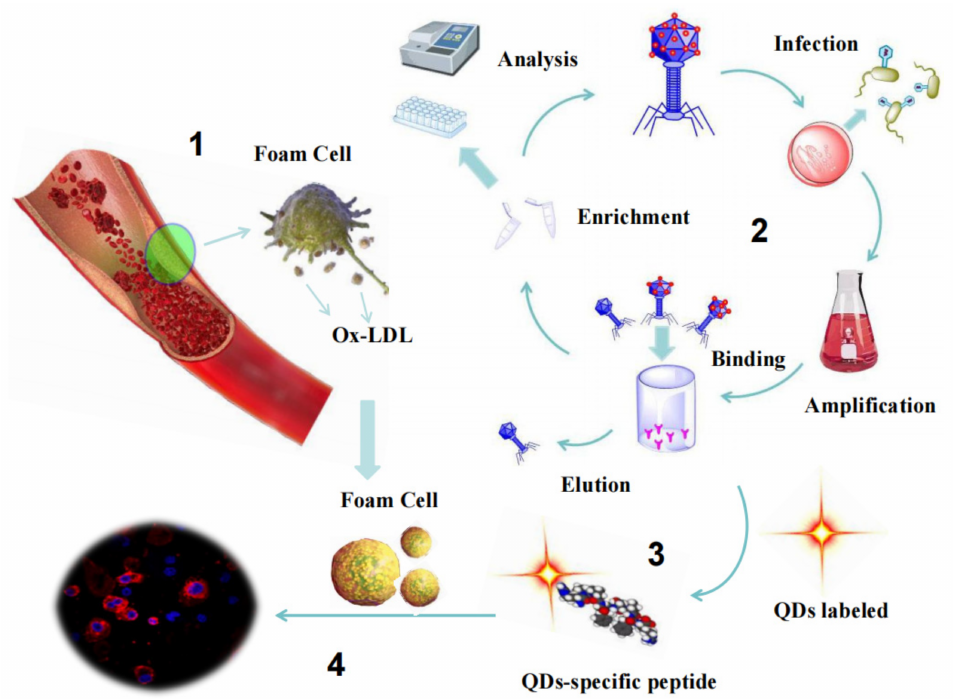
Figure 1. Flow chart of polypeptide preparation by phage